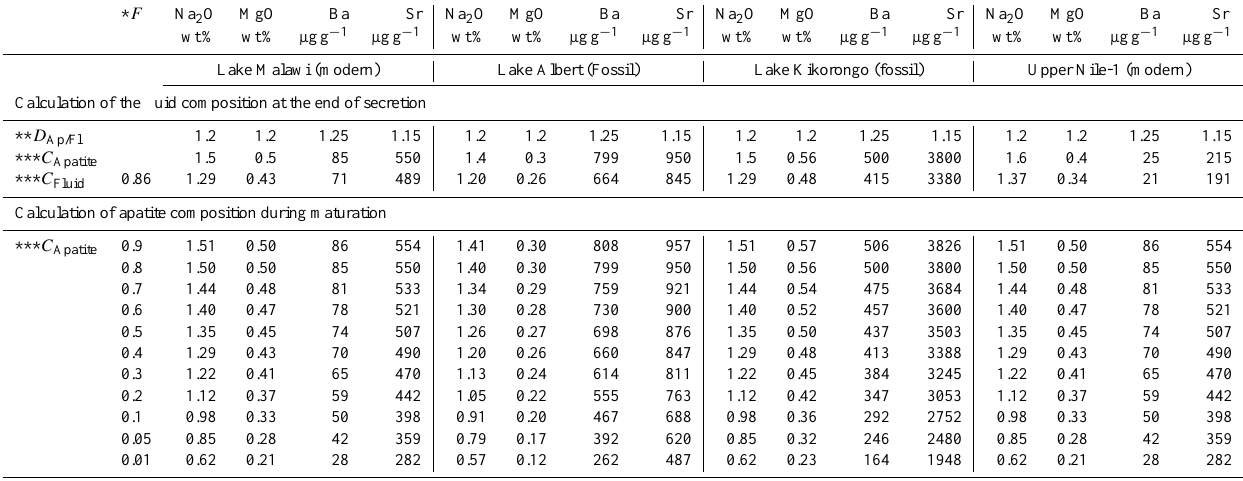
Table 2. Rayleigh crystallization model for enamel